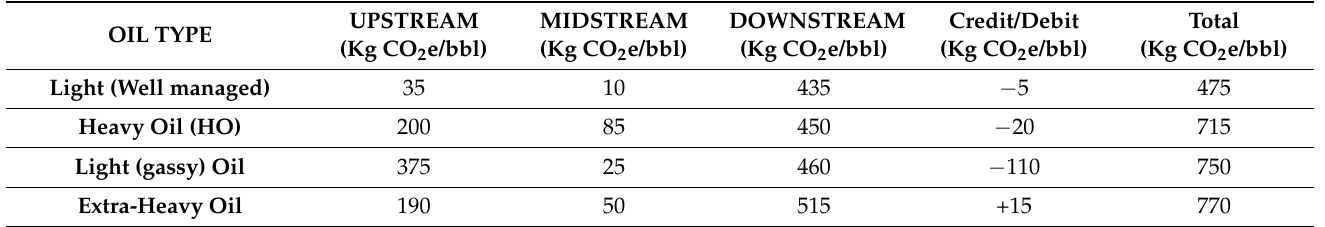
Table 1. Total Green House Gas (GHG) Emissions for Oil Quality (after [12]